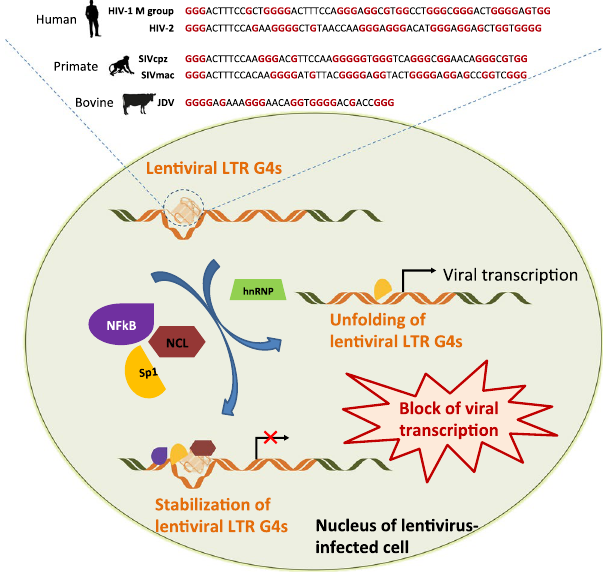
Figure 5. Model of transcription regulation in lentiviruses based on the 5 ′ -LTR G4s. Sp1 and NFkB are transcription factors, NCL stands for the cellular protein nucleolin 27 , hnRNP stands for heterogeneous nuclear ribonucleoproteins. Human and animal silhouettes were obtained at http://www.freepik.com and http://www. flaticon.com/ (http://www.freepik.com/free-vector/business-team-outlines-pack_831669.htm#term =